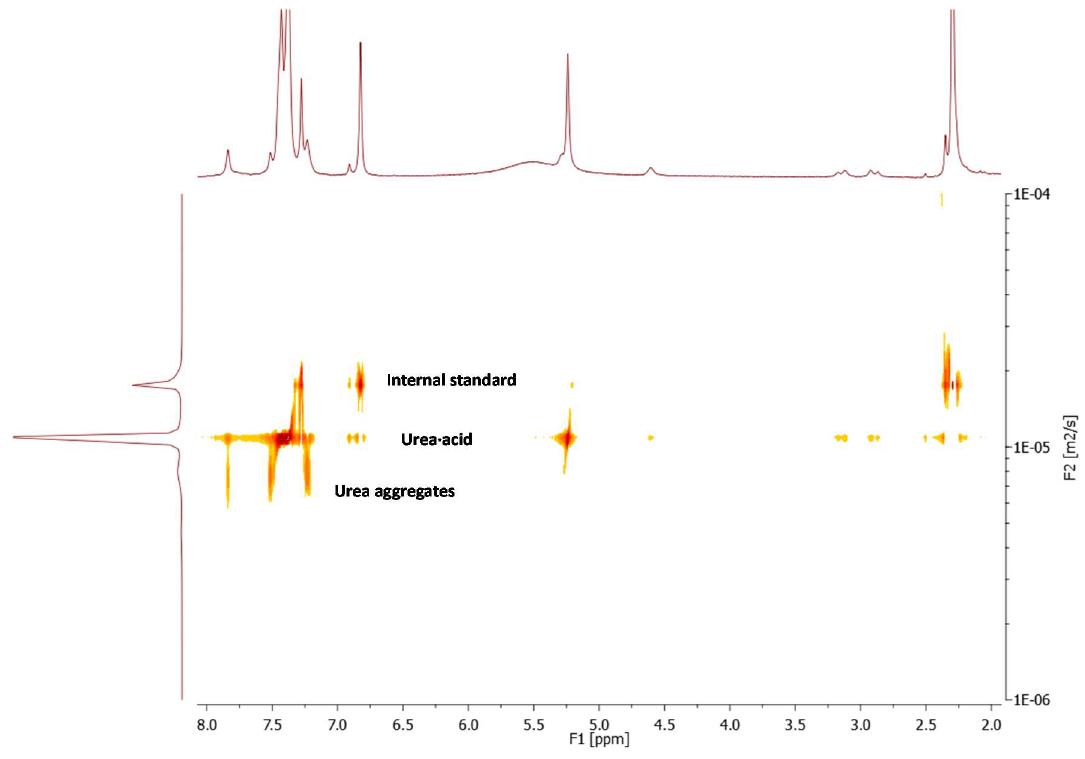
Figure 5. DOSY NMR experiment in CDCl 3 (300 MHz).